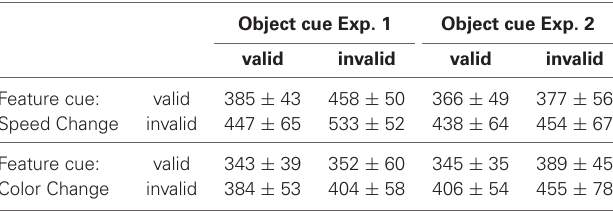
Table 1 | Absolute mean RTs ± SD [ms] for the four different cueing conditions of Exp. 1 and Exp. 2 . Object cue Exp. 1 Object cue Exp.